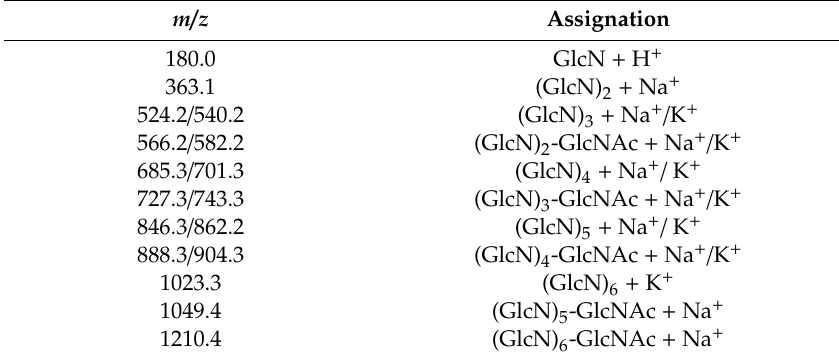
Table 1. Main identified signals in the MALDI-TOF mass spectrum of the reaction between chitosan CHIT600 and Neutrase 0.8 L. Reaction conditions were as described in Figure 2.